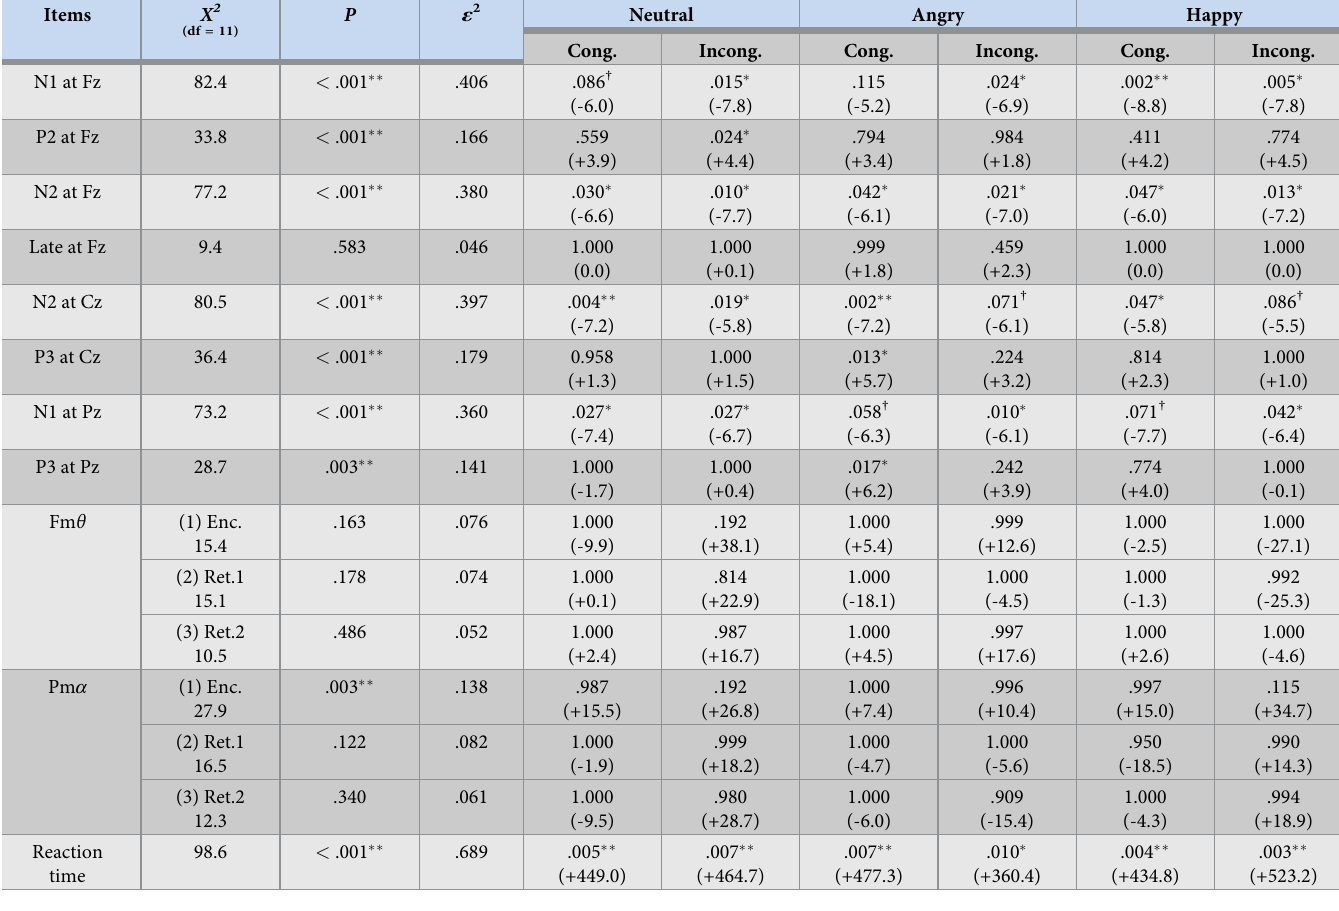
Table 7. Preschool children versus young adults in evaluation